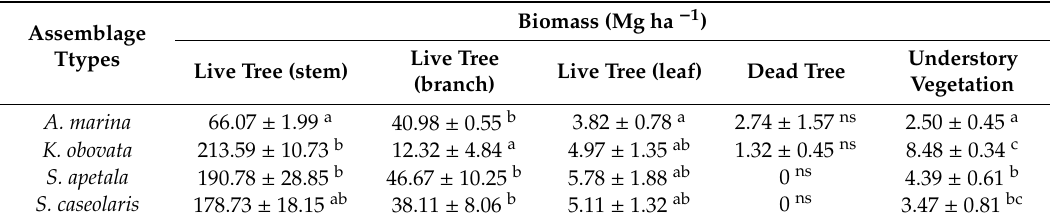
Table A2. Biomass of each mangrove assemblage of field sampling.